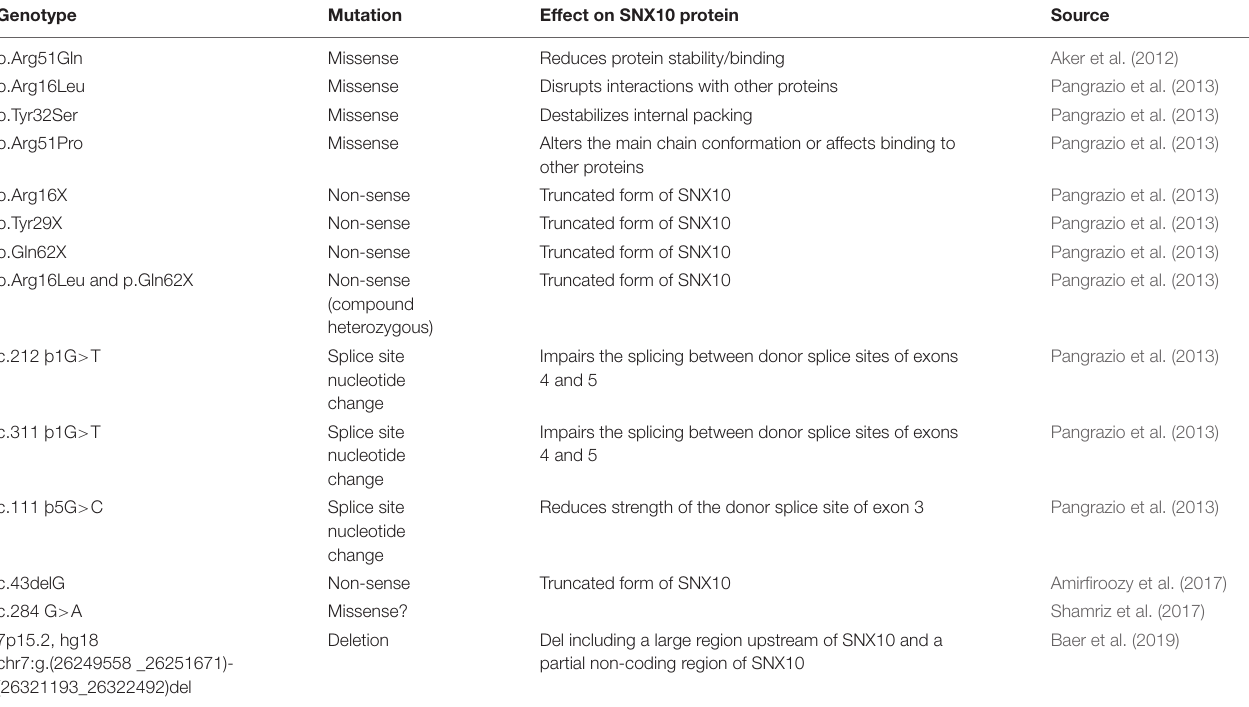
TABLE 1 | Osteopetrotic SNX10